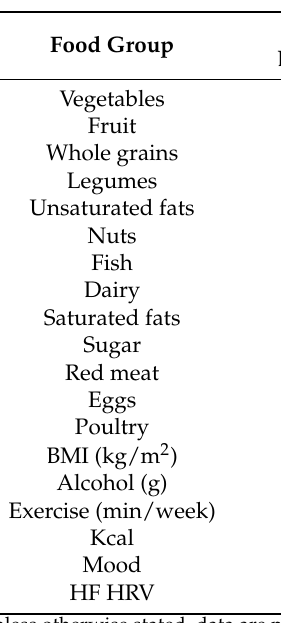
Table 1. WISH dietary components contributing to each cluster.